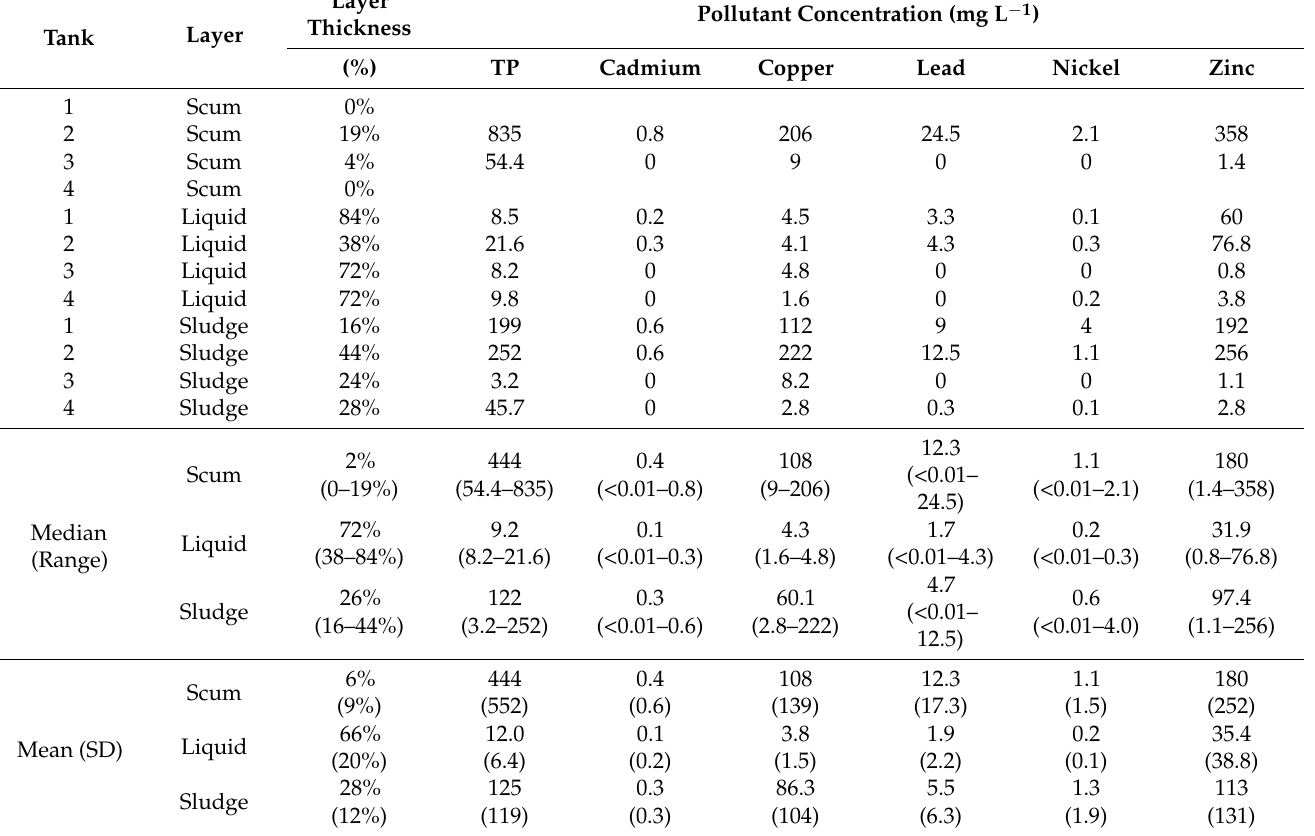
Table 5. Individual, median (range), and mean (standard deviation (SD)) concentrations of total phosphorus (TP) and trace metals in septic tanks that had not been pumped in at least 8